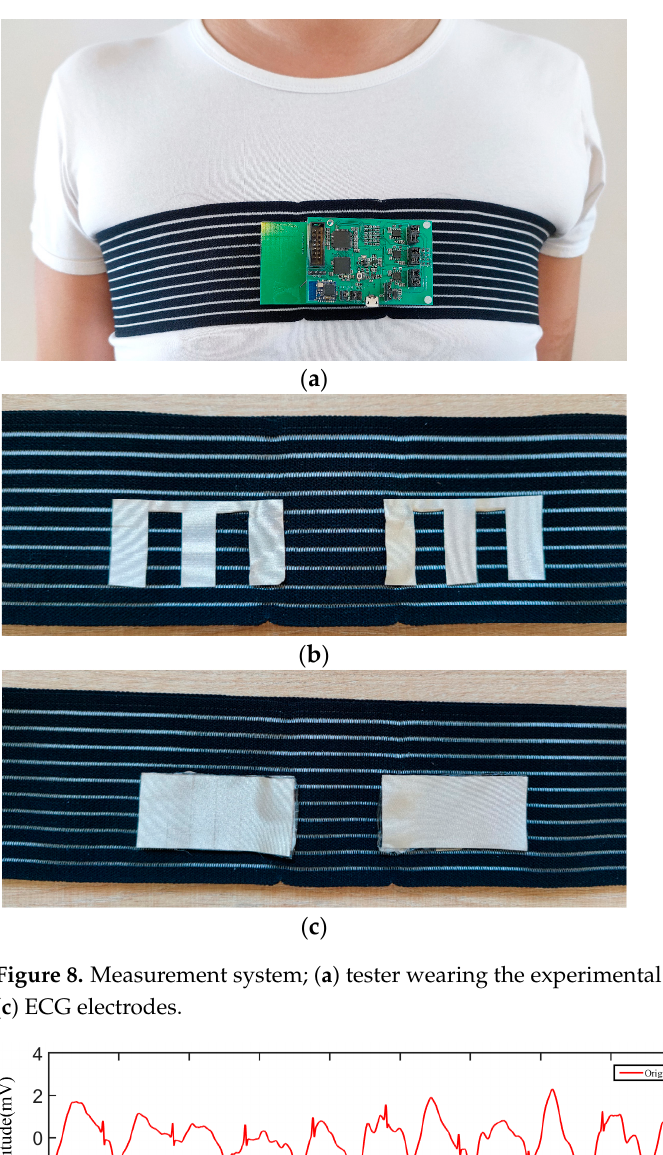
Figure 8. Measurement system; ( a ) tester wearing the experimental device; ( b ) reference electrodes; ( c ) ECG electrodes.